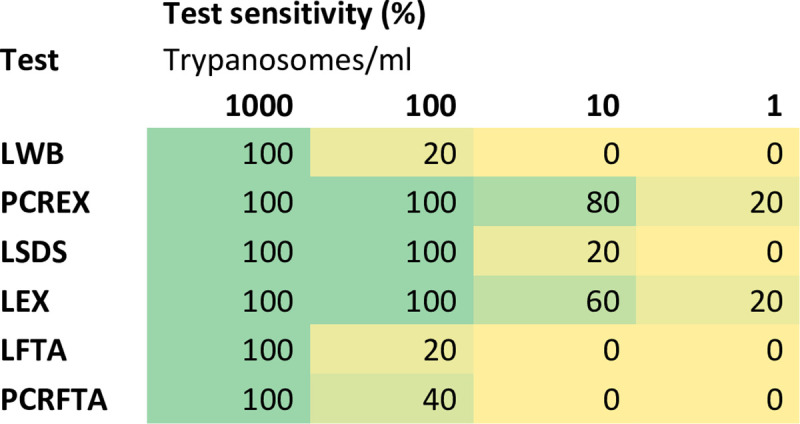
Threshold study: Test sensitivity at varying parasite concentrations in blood.The ability of various tests to detect trypanosomes at concentrations varying from 1000 trypanosomes/ml to 1 trypanosome/ml was assessed. The results are depicted in the form of a heat map with detection ranging from 100% to 0% across the various samples and tests. LWB: LAMP on whole blood template; LSDS: LAMP on whole blood treated with SDS detergent; LEX: LAMP on DNA extracted from whole blood; LFTA: LAMP on DNA extracted from FTA cards; PCREX: TBR-PCR on DNA extracted from whole blood; PCRFTA: TBR-PCR on DNA extracted from FTA cards.